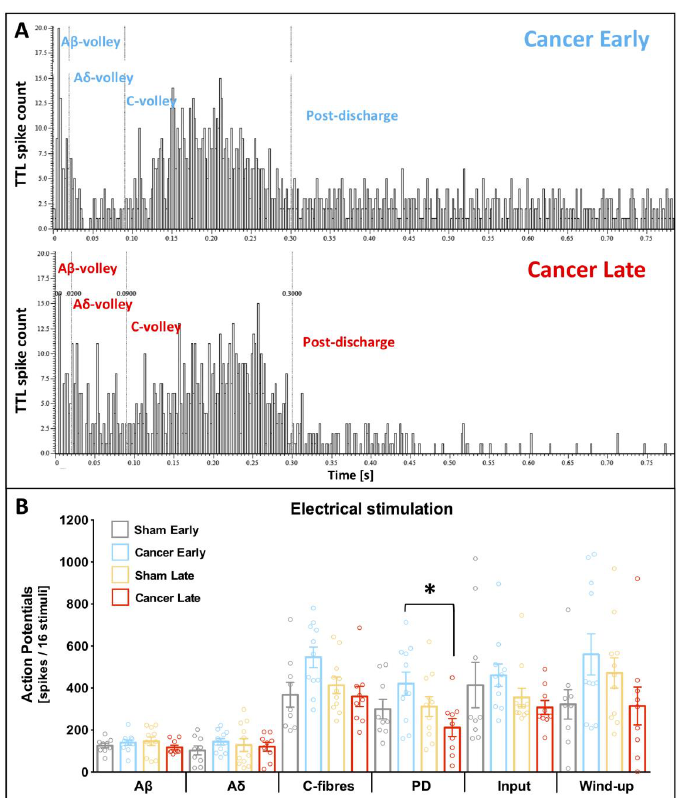
Figure 3. Deep dorsal horn wide dynamic range neurons exhibit shortened post discharge in the late cancer stage. ( A ) Examples of the post-stimulus histograms generated from a single cell deep dorsal horn (lamina V) wide-dynamic range (WDR) neuronal responses recorded in vivo from anaesthetised early (day 7/8, top panel) and late (day 14/15, bottom panel) cancer stage rats. Rats received subcutaneous injection of the current to the peripheral receptive field located on the ipsilateral paw: train of 16 stimuli, 0.5 Hz, 2 ms pulse width, 7.8 ± 1.2 mA mean current. ( B ) Electrically-evoked responses of lamina V WDR neurons in early (day 7–8) and late (day 14–16) cancer stage and corresponding sham-operated rats. Each dot represents one animal. One-way ANOVA with Bonferroni post-hoc: all p > 0.05, but post discharge (PD) * p < 0.05 cancer early vs. cancer late. All the data represent the mean ± SEM from sham early ( n = 9), cancer early ( n = 11), sham late ( n = 11) and cancer late ( n =